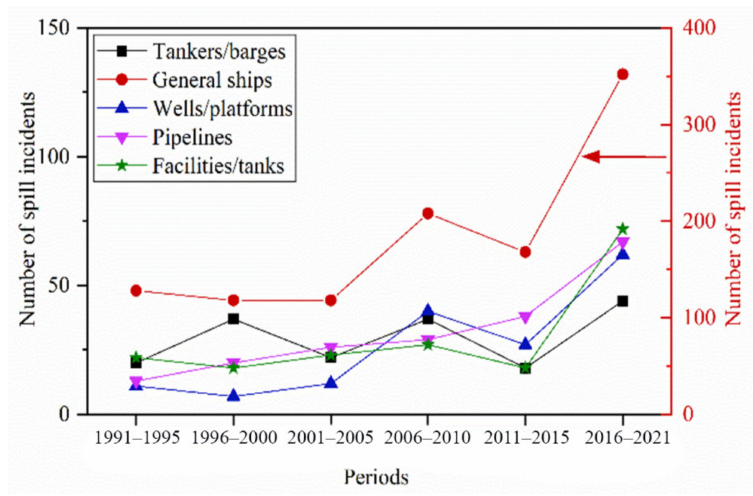
Figure 2. Numbers of reported oil spills in the United States from 1991 to